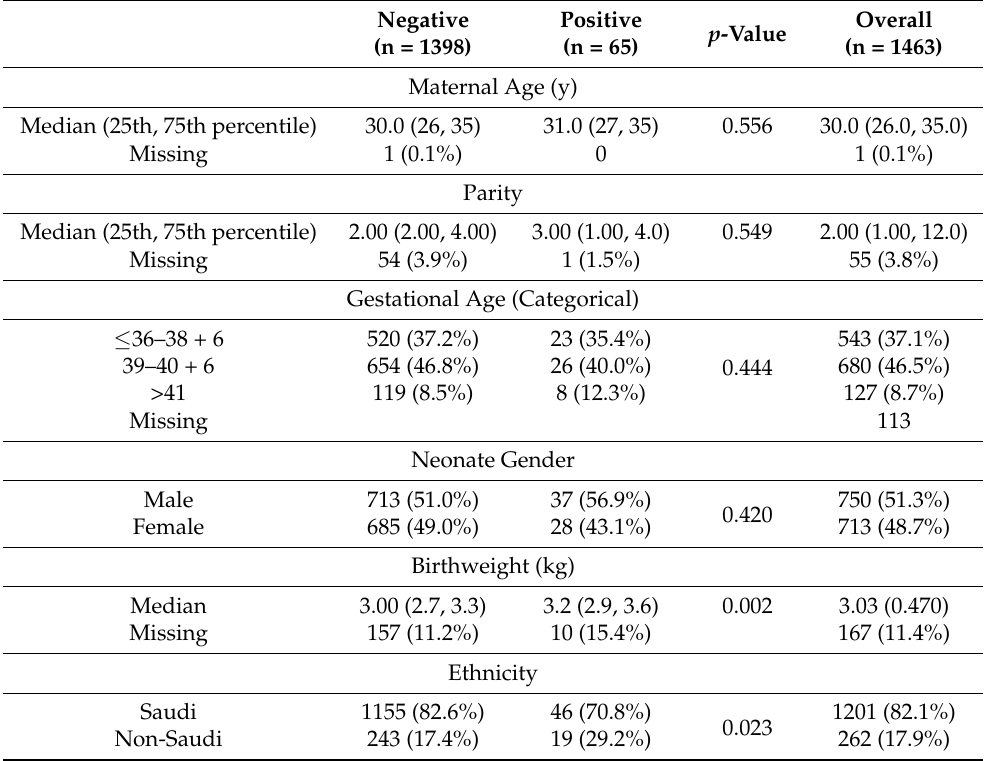
Table 1. Demographic and clinical characteristics of study population by DAT results (n = 1463). p -Value calculated by chi-square for categorical data, and Mann–Whitney U test for continuous variables. Negative (n =